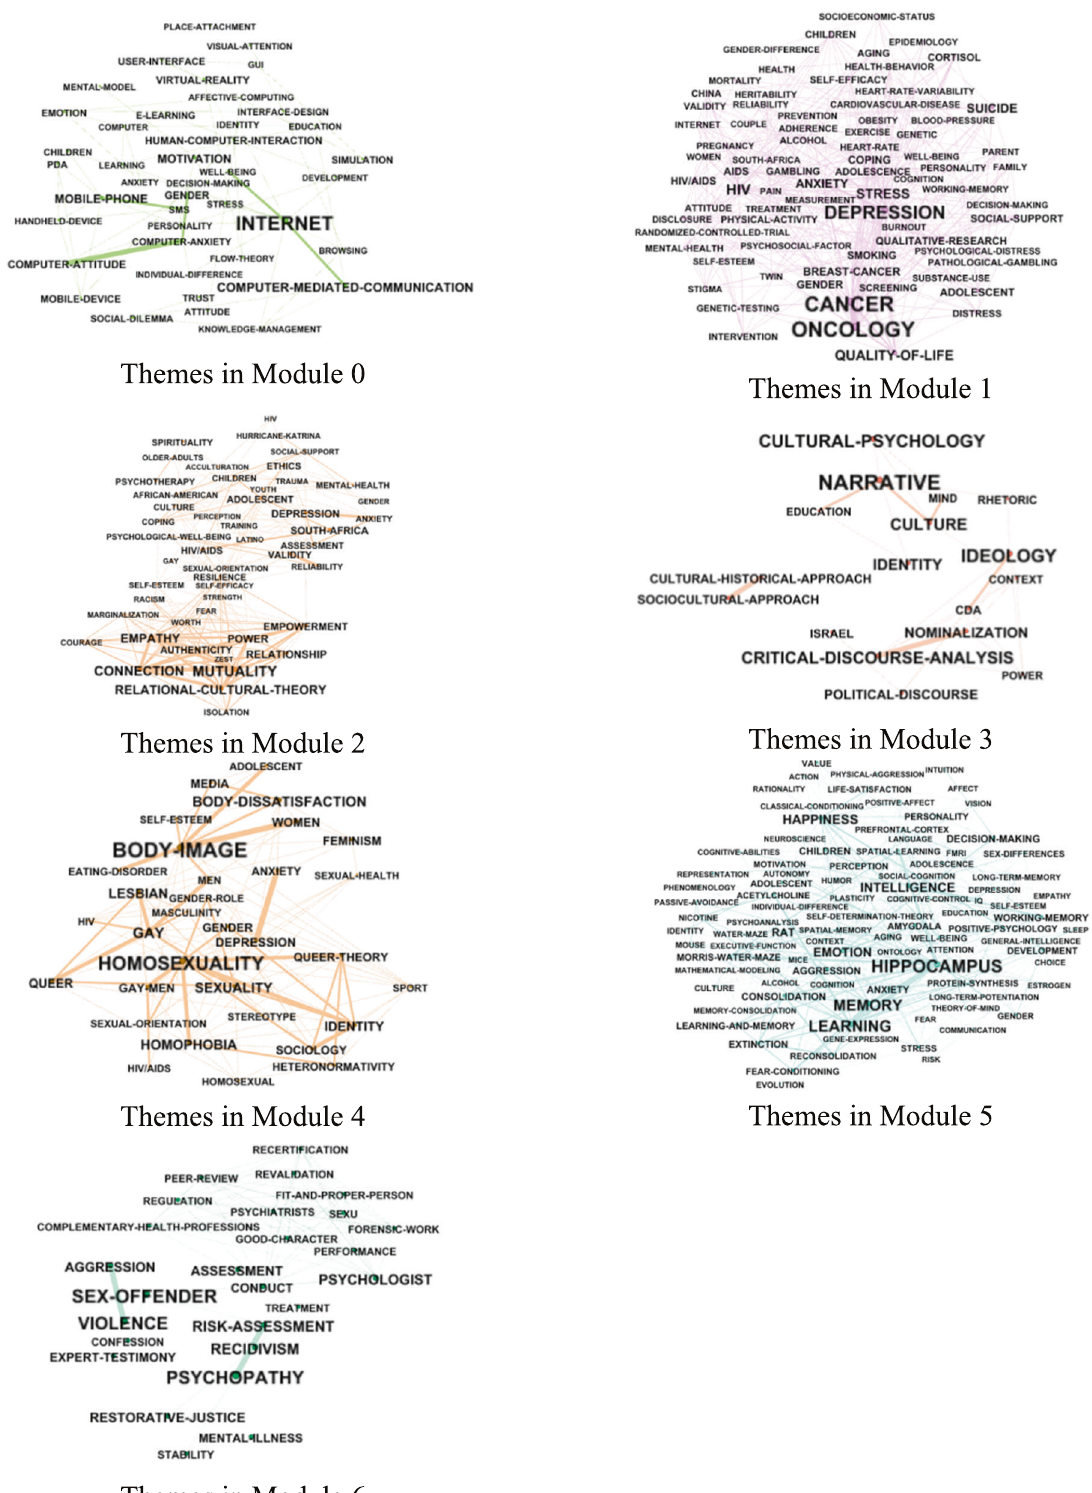
Fig. 3 Keywords found in each module identi fi ed in the 2008 citation network. The size of the node re fl ects the number and weight of the degree (i.e., larger nodes had many connections and highly weighted connections). The thickness of the connection indicates the weight of the connection (i.e., connected nodes with thick lines co-occurred many